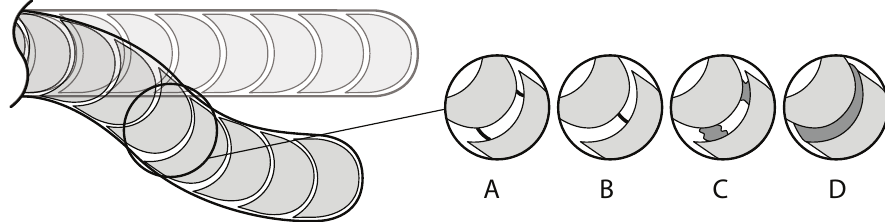
Figure 3. Segments locking solutions: the segments composing the structure can be locked by several inter-segment elements as: ( A ) multiple tensioning wires; ( B ) a central tensioning wire; ( C ) bellows-like connections; ( D ) soft material